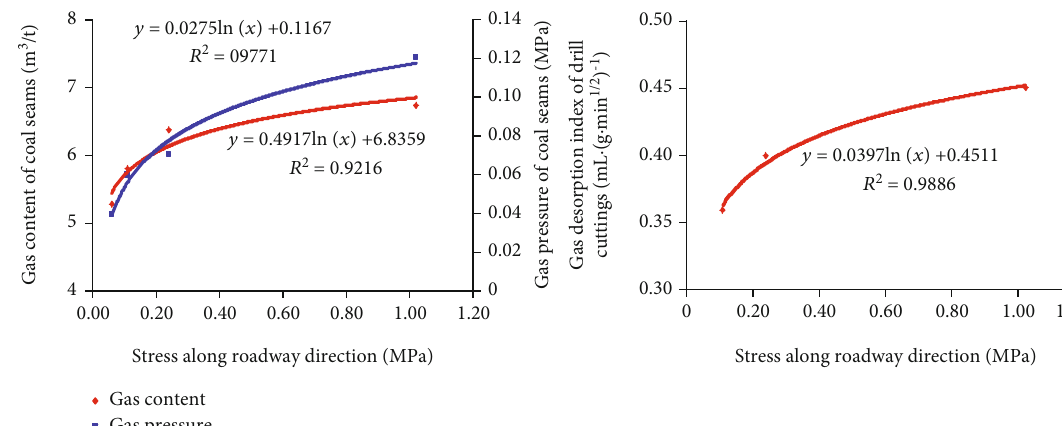
Figure 18: The relationship between stress change along the roadway and gas parameters.